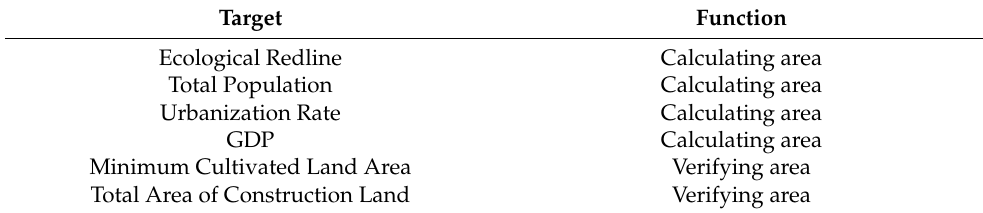
Table 1. Target system for optimizing county-level land-use